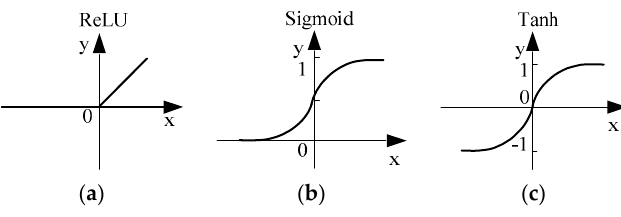
Figure 4. Activation function curve: ( a ) ReLU; ( b ) Sigmoid; ( c ) Tanh.